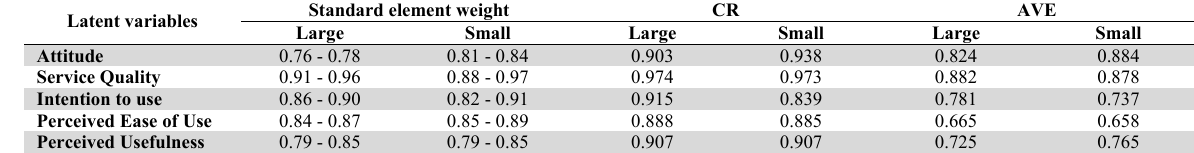
Standard element weight CR AVE Latent variables Large